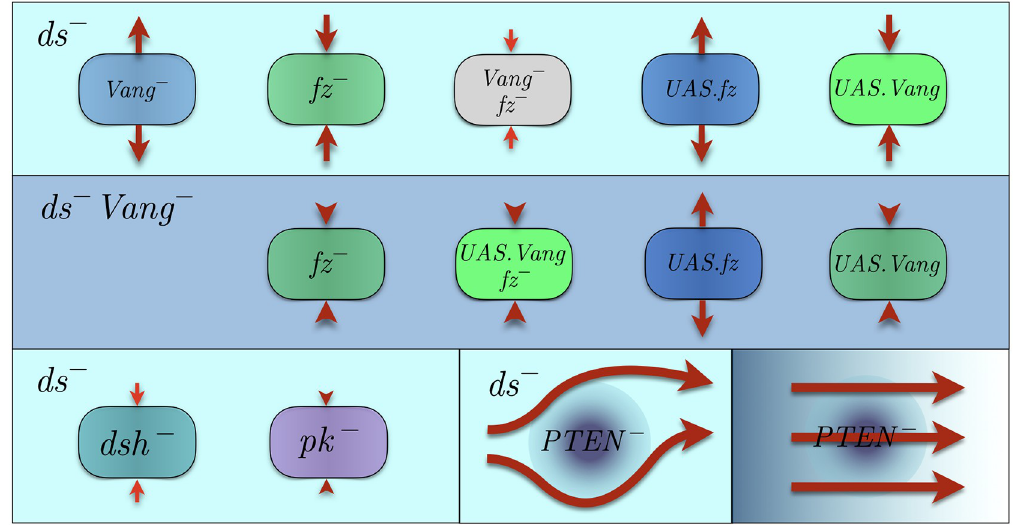
Fig 6. First and second rows illustrate various clones embedded in ds − and ds − Vang − backgrounds, respectively; ds − implies the absence of global cue. Since Fz and Vang appear on an equal footing in the model, the background mutants are only shown for Vang − tissues. The corresponding phenotypes in fz − background, are obtained by replacing Fz and Vang and flipping the arrows. The colors of the background and clones are chosen as follows: blue and green represent Fz and Vang, respectively. Together, Fz and Vang make the cyan background in the first row. Lack of either one is represented by the complementary color. The left panel of the third row shows mutants lacking cytoplasmic proteins in ds − background. Red arrows must be interpreted as the directions of the polarity distortion measured with respect to the wild-type polarity; not the direction of the resulting polarity (see S7 Fig for further clarification). The thickness and length of an arrow indicate the magnitude and spatial extension of non-autonomy, respectively. The right two panels of the third row correspond to the geometrically disordered clones, with and without global graded cues. In this case the arrows show the resulting polarization